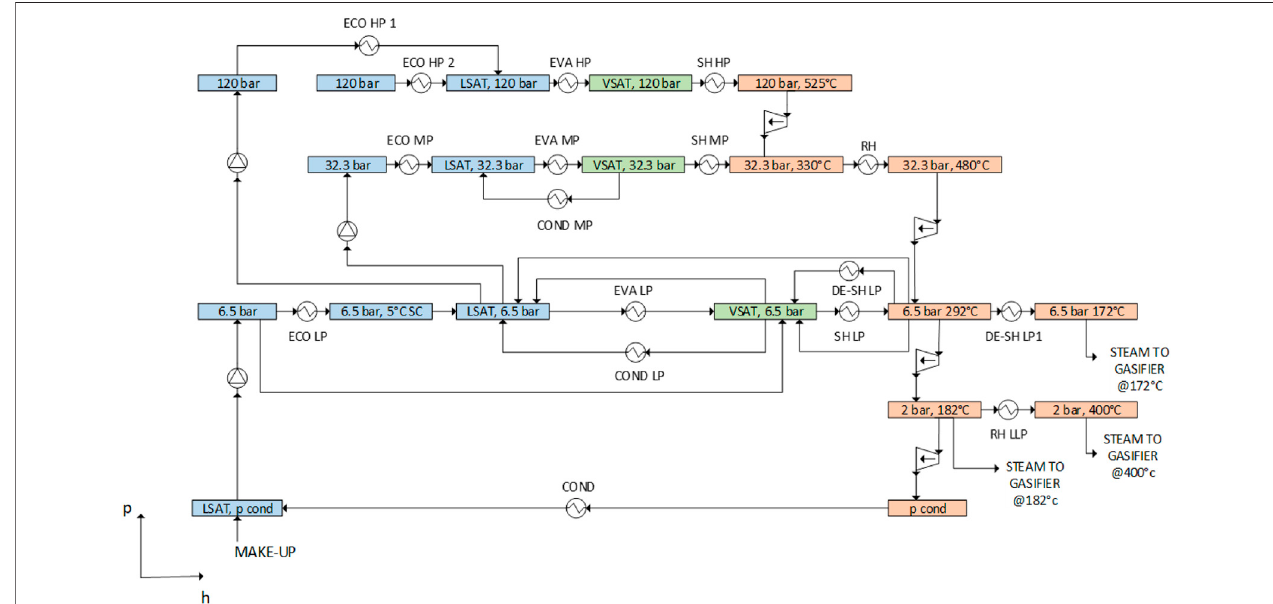
FIGURE 5 | Scheme of the p-h superstructure representing the possible HRSC con fi gurations. Colored boxes denote steam/water headers at fi xed pressures and temperatures, which are connected by equipment units (pumps, economizers, evaporators, superheaters, and valves), as described by Elsido et al.